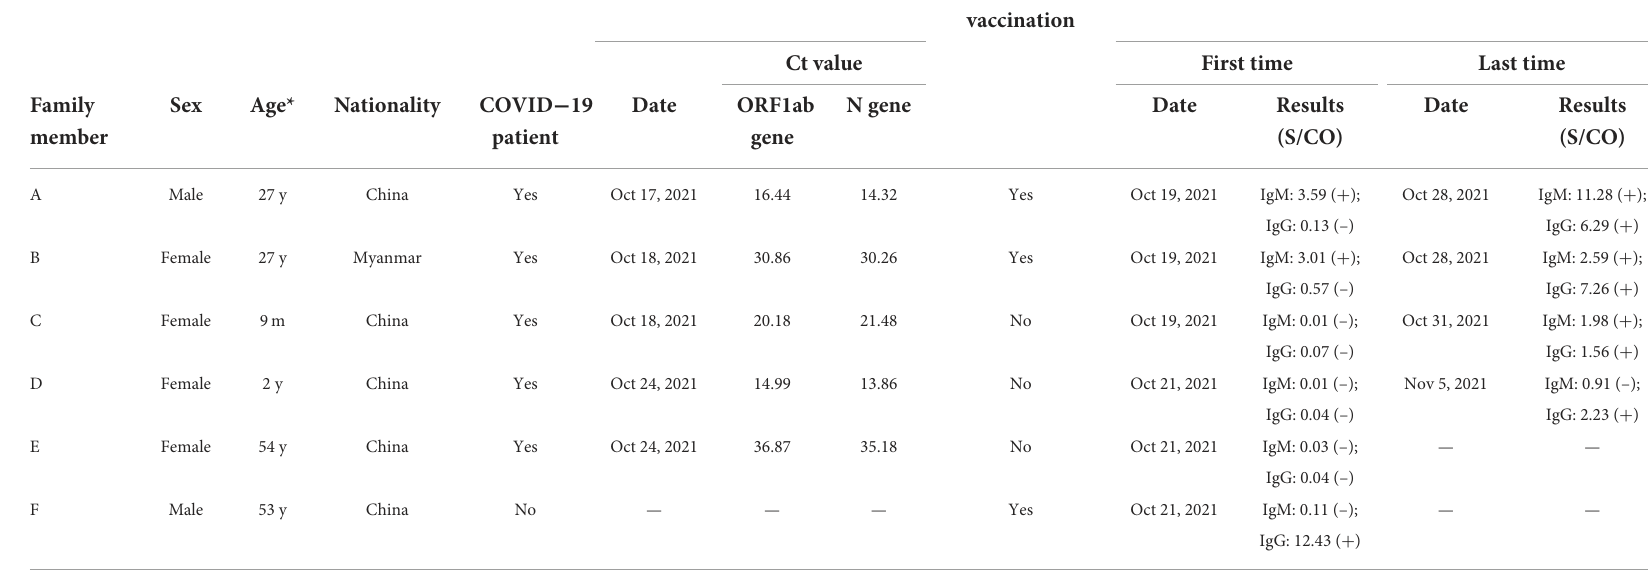
TABLE 1 Characteristics of the index case and his family